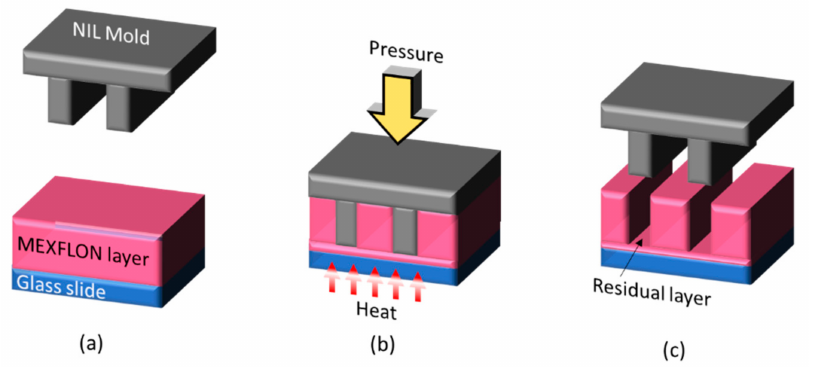
Figure 6. Micropattern fabrication process with a RIM material using thermal nanoimprint lithogra- phy for TIRFM: ( a ) deposition; ( b ) thermal nanoimprint; ( c ) cooling and